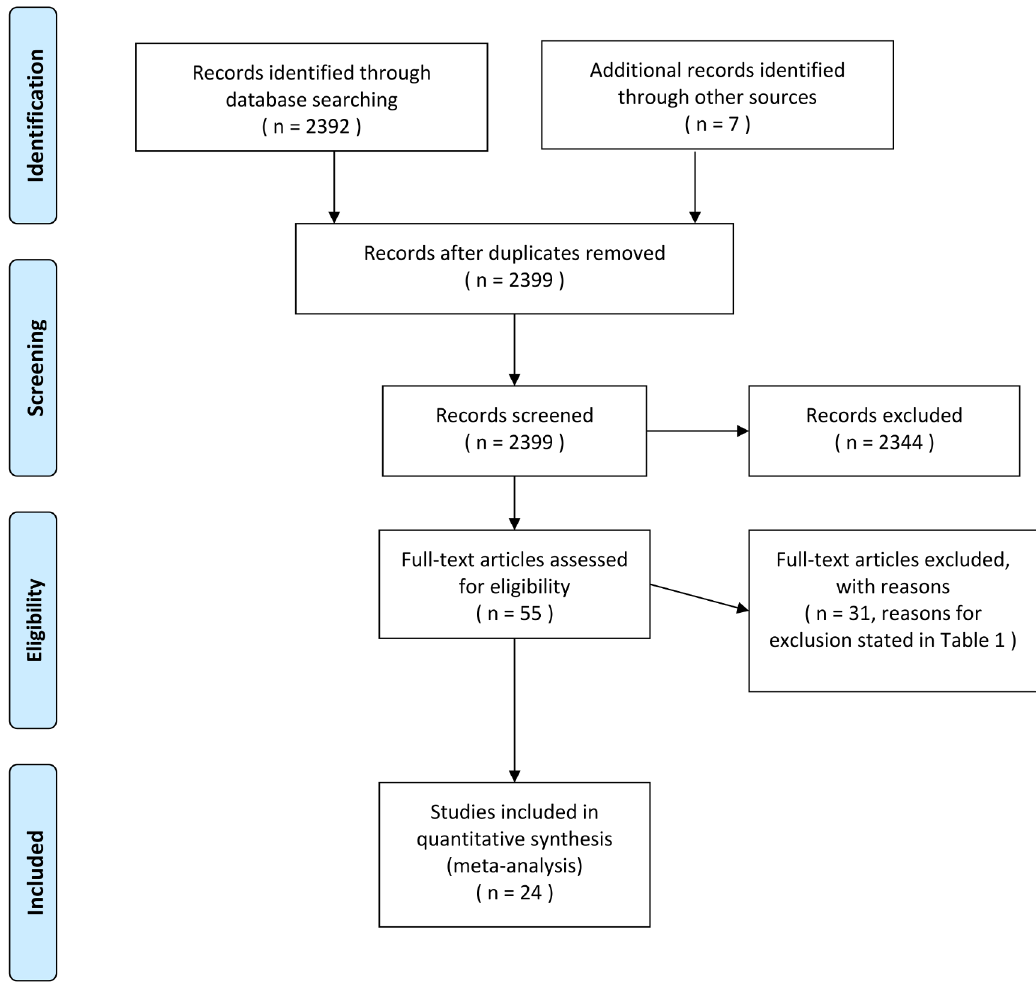
Fig 1. Flow diagram of the search strategy.